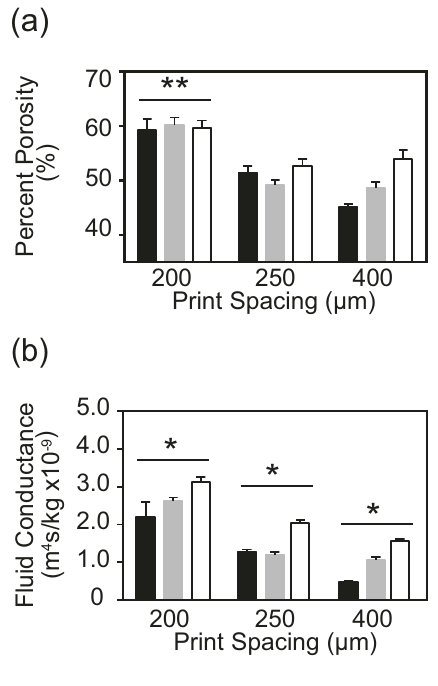
Fig. 6 a Porosity of the scaffolds printed with varying tip diameters and print spacing. Scaffolds printed with thinner tip diameters (200 µm) exhibited signi fi cant (** p < 0.001) increased porosity. b Fluid Conductance through the scaffolds printed with various tip diameters and print spacing. The scaffolds printed with different tip diameters displayed signi fi cant (* p < 0.02) differences in fl uid con- ductance from each other. The scaffolds printed with the smallest tip diameter (200 µm) and largest print spacing (1.8 mm) displayed the highest conductance. PrSp print spacing, TipD tip